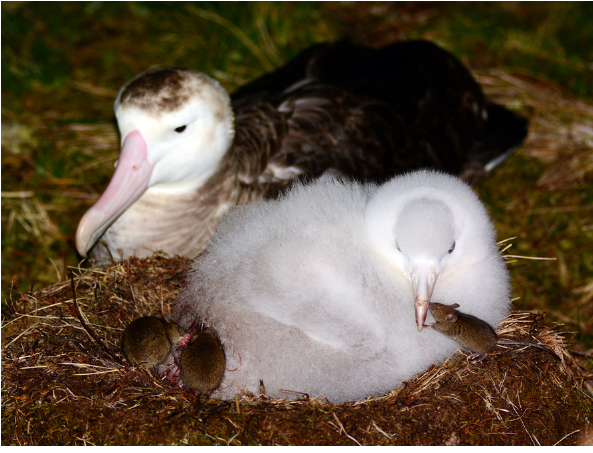
Fig. 2 . A six week old Tristan Albatross ( Diomedea dabbenena ) chick is attacked by mice despite the parent being present at the nest. This chick died 3.3 days after the first mouse